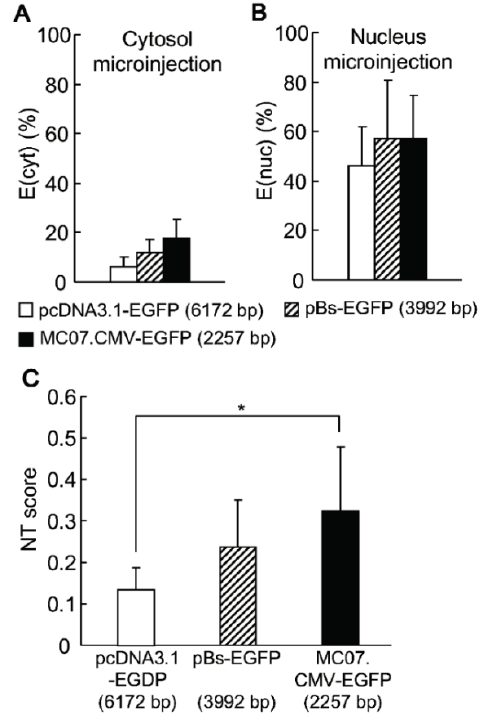
Figure 3. EGFP expression after the cytoplasmic and nuclear microinjection of naked DNA. One thousand copies and 10 copies of three types of DNAs (MC07.CMV-EGFP,